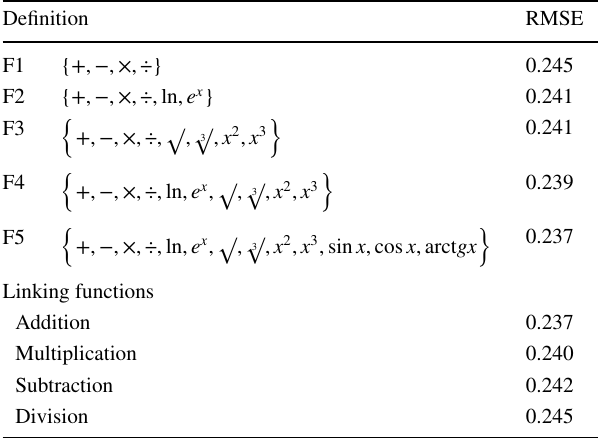
Table 8 Testing results of different functions set and linkage function for developing GEP for USGS 06892350 station